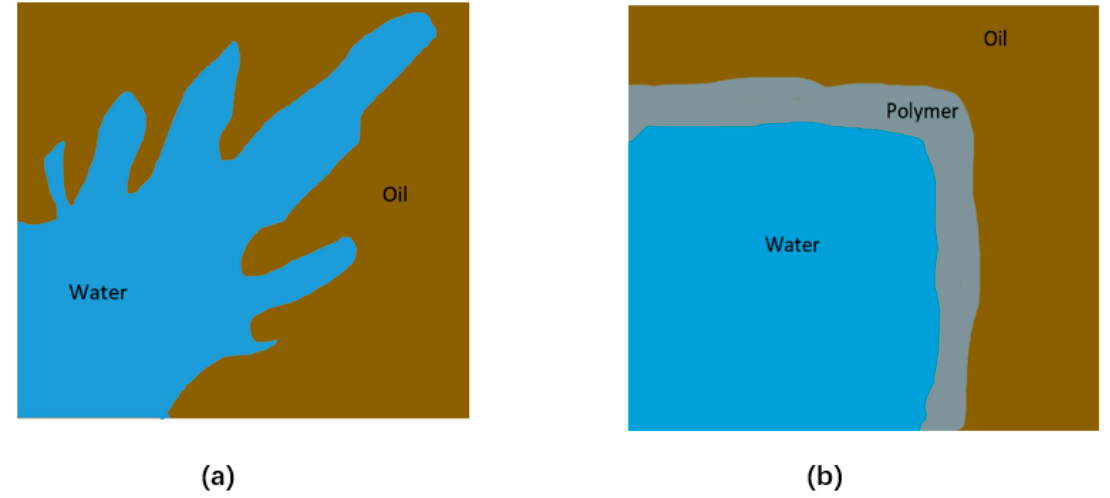
Figure 11. The effect of viscous fingering on water flooding: ( a ) unfavorable mobility ratio; ( b ) favorable mobility ratio with polymer treatment.